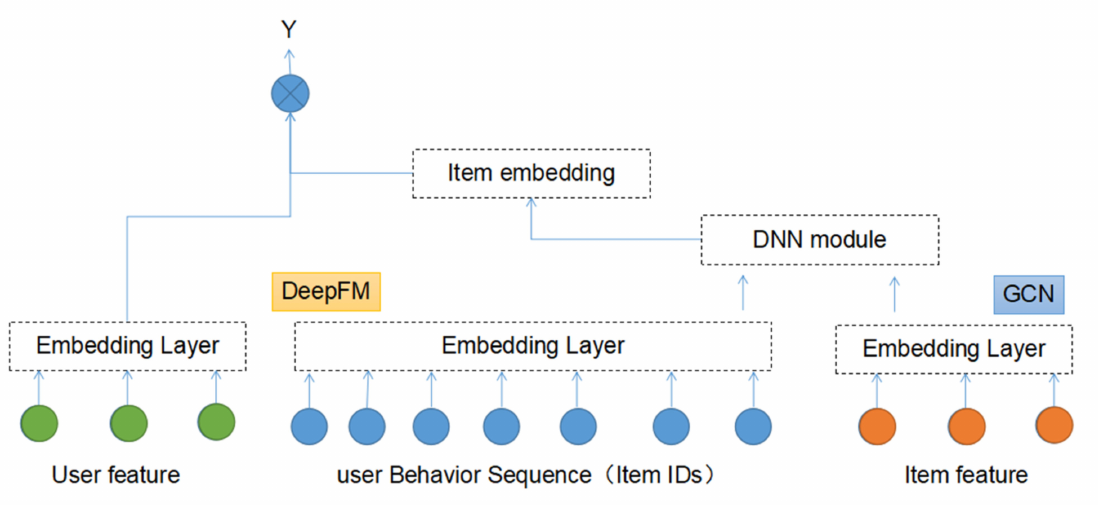
Figure 4. The diagram of user embedding and item